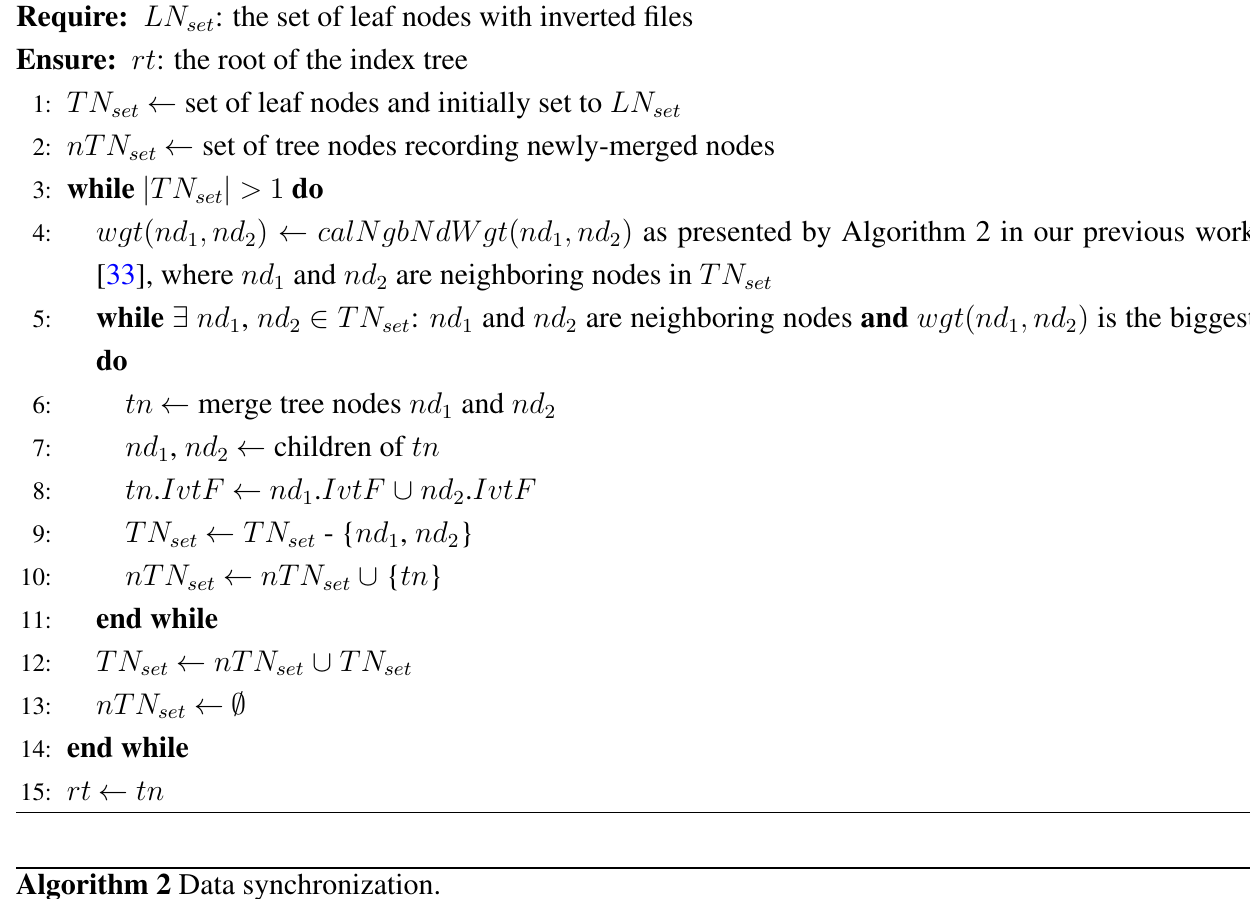
Algorithm 1 Index tree construction.